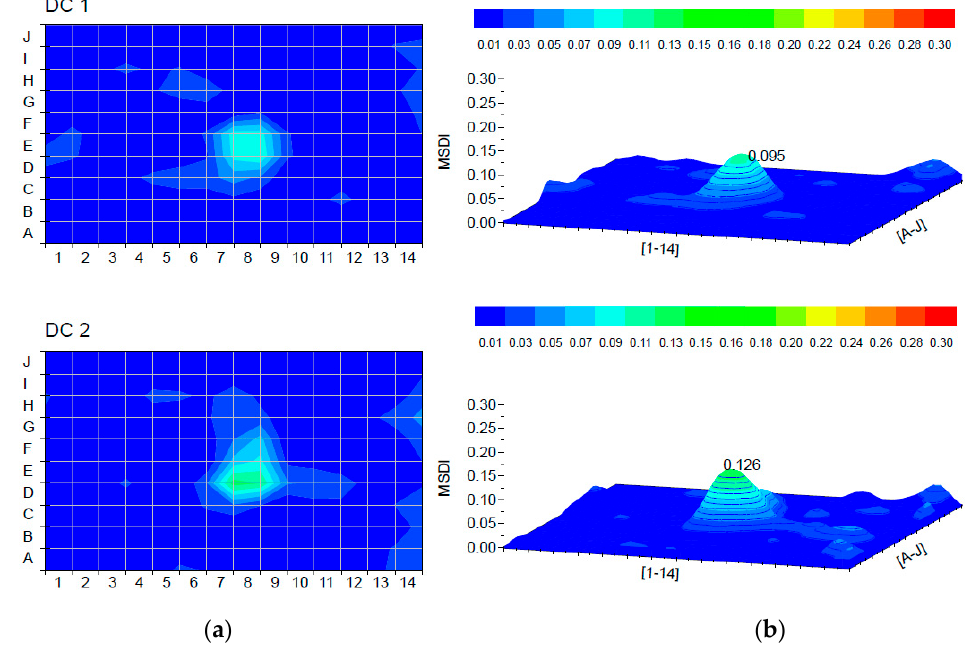
Figure 6. Damage localization for damage cases DC1 and DC2: ( a ) 2D; ( b ) peak values in 3D.